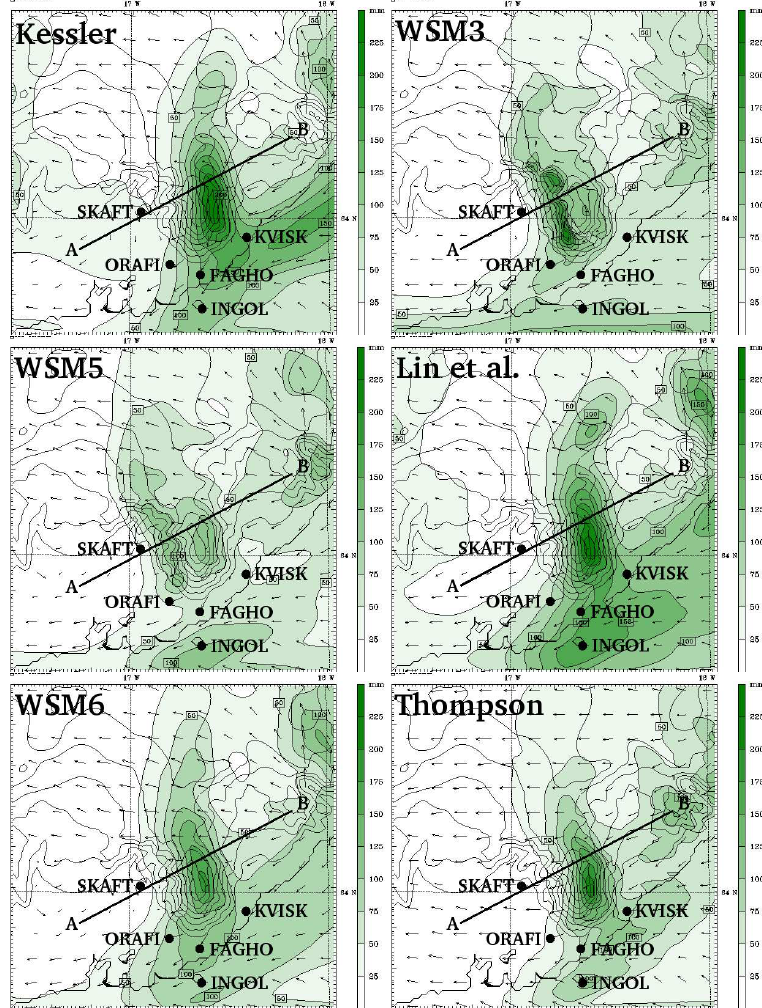
Figure 7: Accumulated precipitation between 1800 UTC 15 September and Fig. 7. Accumulated precipitation between 18:00UTC 15 September and 09:00UTC 16 September 2004. micro-physics schemes are, from 0900 UTC 16 September 2004. micro-physics schemes are, from top left to bot- top left to bottom right: Kessler, WSM3, WSM5, Lin et al., WSM6 and Thompson. tom right: Kessler, WSM3, WSM5, Lin et al., WSM6 and Thompson.